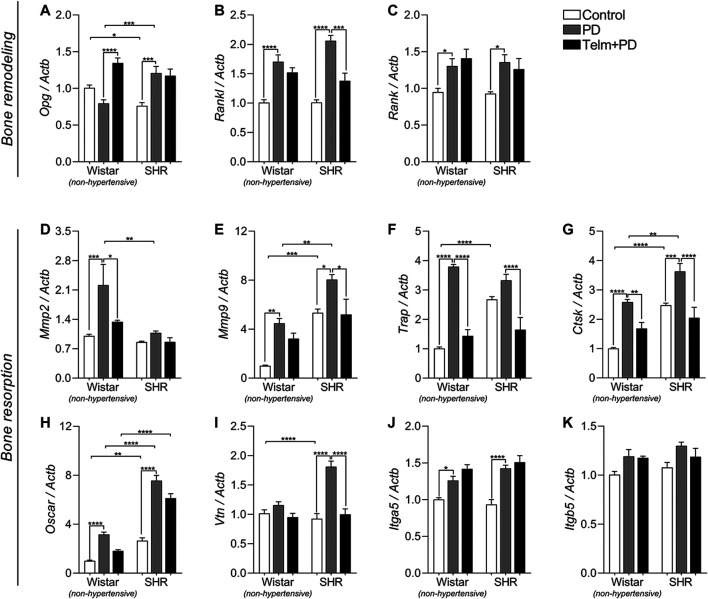
Bone remodeling and resorption markers expression in mandibles of Wistar (non-hypertensive) and SHR with PD 15 days, treated with telmisartan. qRT-PCR for Opg
(A), Rankl
(B), Rank
(C), Mmp2
(D), Mmp9
(E), Trap
(F), Ctsk
(G), Oscar
(H), Vtn
(I), Itga5
(J), and Itgb5
(K). Graphs shown mean ± SEM (n = 6). Statistical difference are represented by brackets labeled by *p < 0.05, **p < 0.01, ***p < 0.001, and ****p < 0.0001, comparing Control vs. PD, PD vs. Telm + PD, and Wistar vs. SHR in the same experimental condition.